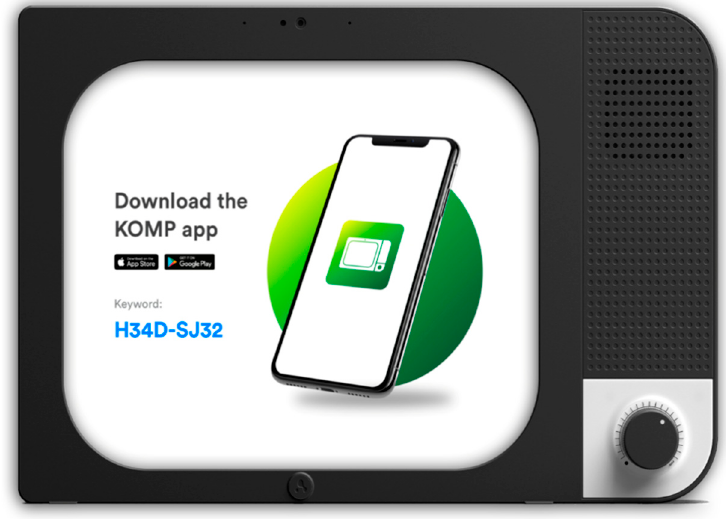
Figure 1. The Komp screen (illustration courtesy of No Isolation).